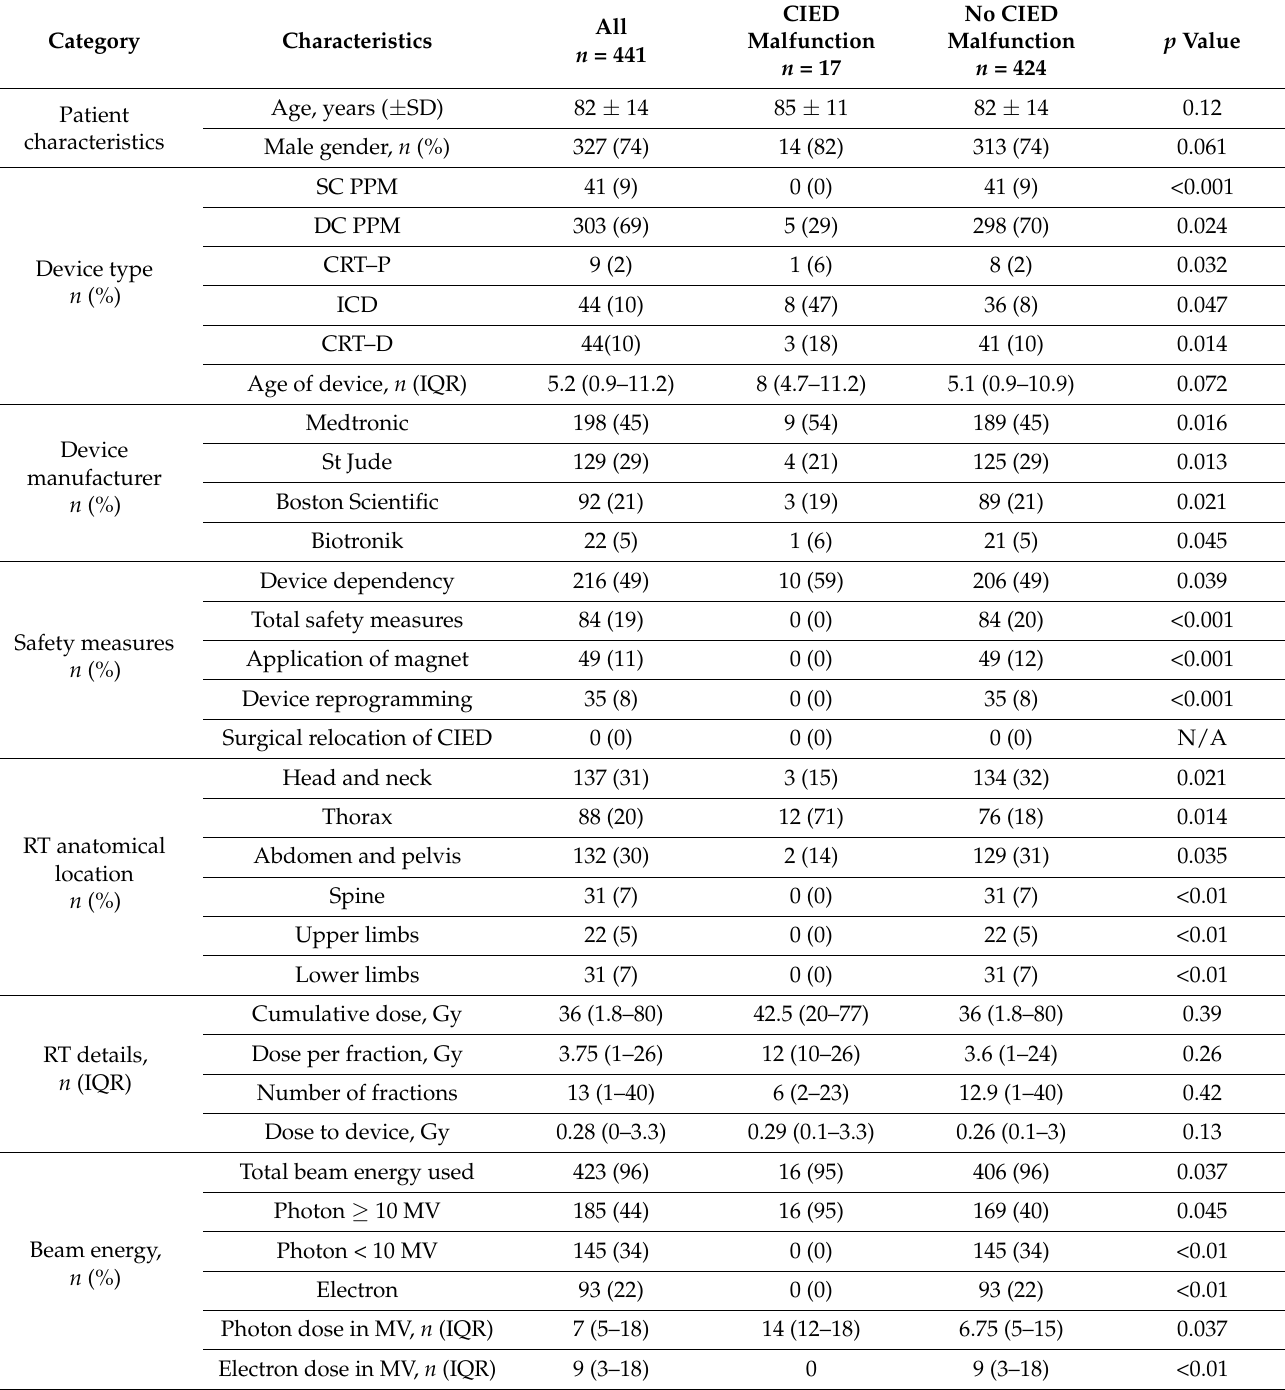
Table 1. Comparison between patient characteristics, CIED data and RT details in patients with CIED malfunction vs. no CIED malfunction with RT. CIED, cardiac implantable electronic device; CRT–P, cardiac resynchronization therapy pacemaker; CRT–D; cardiac resynchronization therapy defibrillator; DC PPM, dual chamber permanent pacemaker; Gy, gray; ICD, implantable cardioverter defibrillator; MV, megavolt; RT, radiotherapy; SC PPM, single chamber permanent